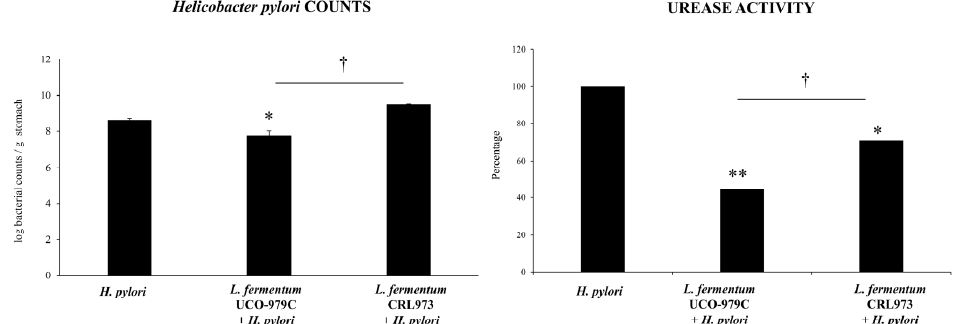
Figure 1. E ff ect of viable L. fermentum UCO-979C or L. fermentum CRL973 on gastric colonization of H. pylori SS1. L. fermentum UCO-979C or L. fermentum CRL973 were administered to di ff erent groups of mice for two consecutive days at a dose of 10 8 UFC / mouse / day, then mice were challenged with H. pylori SS1. Two days post-infection, mice were euthanized. H. pylori counts (Log CFU / g of tissue) and Urease activity (% percentage) were determined in gastric explants. Mice infected with H. pylori were used as controls. The results represent three independent experiments and are expressed as mean ± SD. Significant di ff erences when compared to the control group: * ( p < 0.05),** ( p < 0.01). Significant di ff erences when compared to the indicated group: † ( p < 0.05). Microorganisms 2020 , 8 , x FOR PEER REVIEW